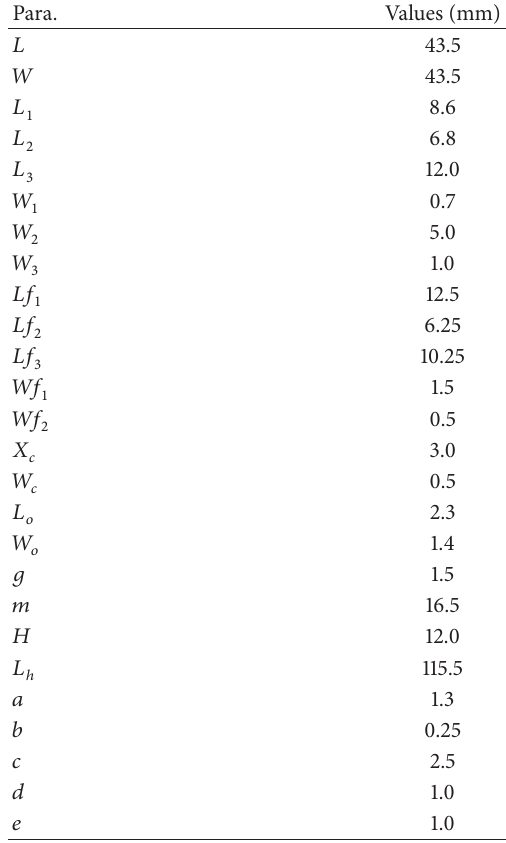
Table 1: Optimized parameters of the proposed antenna.